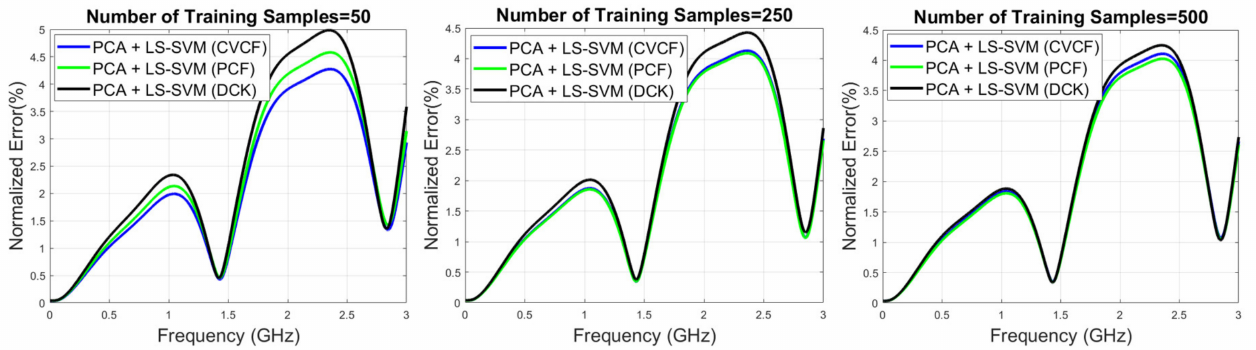
Figure 3. Comparison of the relative NRMSE values computed by the proposed approaches on the test samples by considering the real part of the S21 parameter of the serpentine delay line structure for an increasing number of training samples (i.e., L = 50, 250,